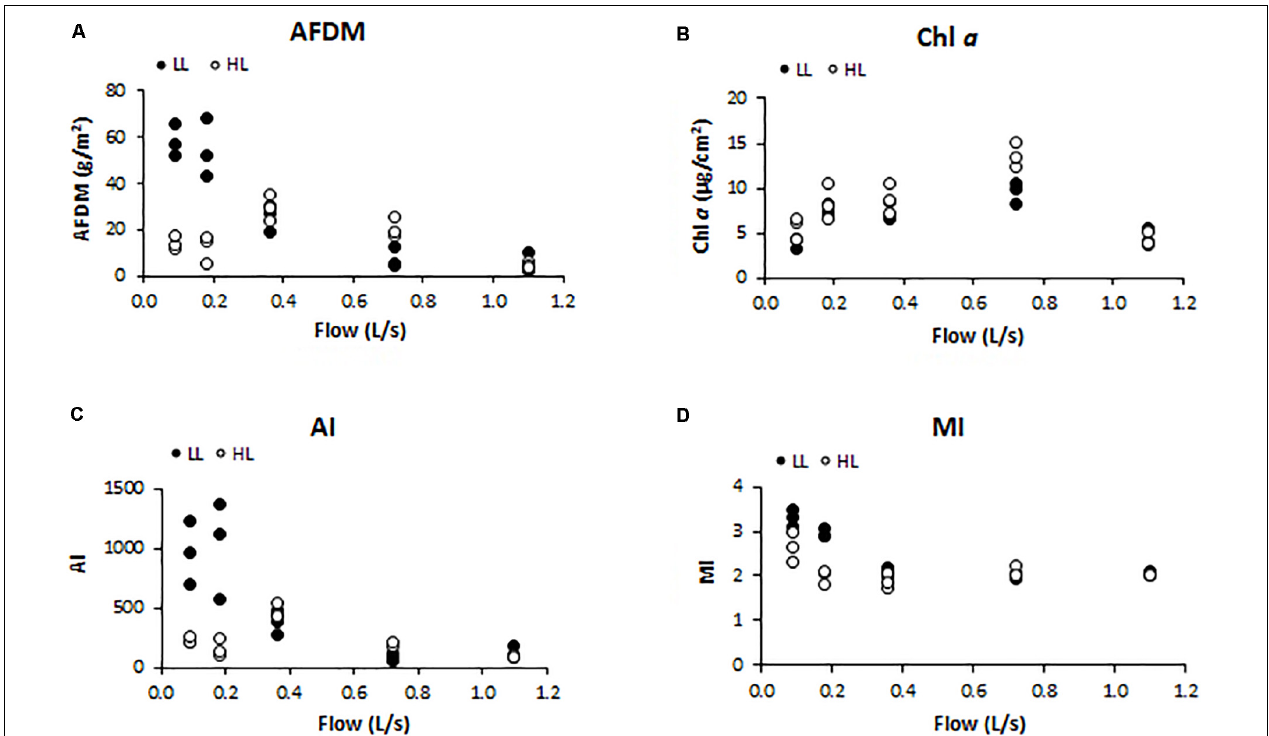
FIGURE 2 | Results obtained in the different treatments for the different structural biofilm descriptors measured at the end of the experiment ( t = 41 days): (A) ash free dry mass (AFDM) (g/m 2 ), (B) Chl a ( µ g/cm 2 ), (C) Autotrophic Index (AI) (AFDM/Chl a ), and (D) Margalef Index (MI) (Abs. 430 nm/Abs. 665 nm).